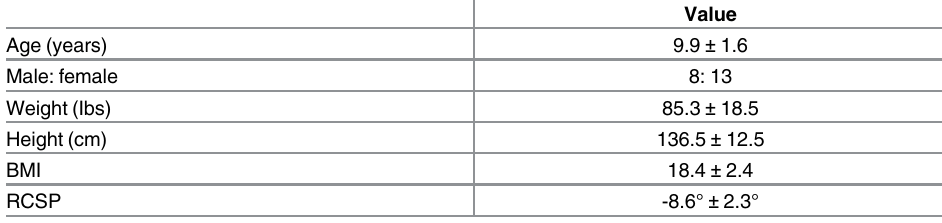
Table 1. Basic demographic characteristics of the participants (N = 21).